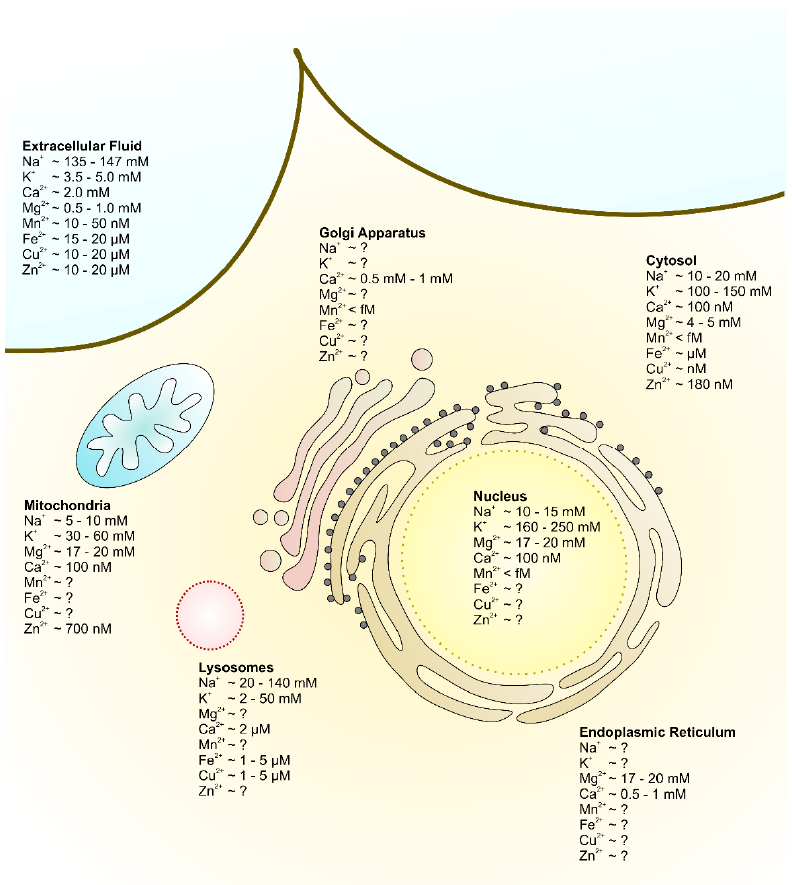
Figure 1. Schematic representation of extra- and intracellular metal ion distributions. Concentrations of the physiologically most relevant metal ions in the extracellular fluid (upper left, light blue) and various cellular organelles including the cytosol (upper right, light brown), nucleus (light yellow), endoplasmic reticulum (brown), Golgi apparatus (red), mitochondrial matrix (blue) and lysosomes (pink) are demonstrated.